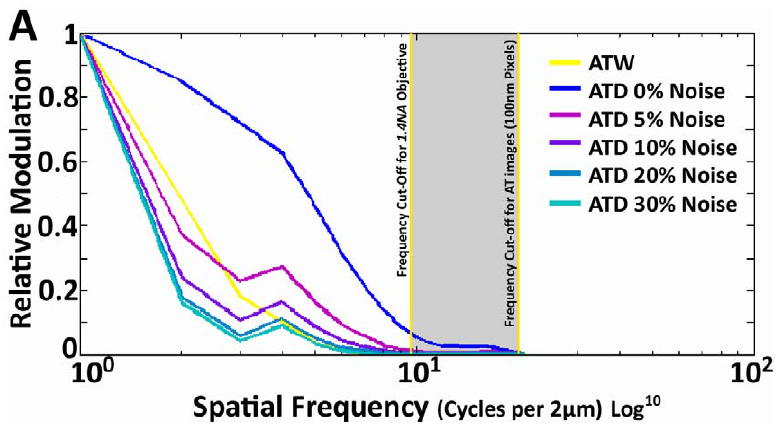
Figure 8. The effect of noise on the spatial frequency recovery of RL deconvolution. (A) This graph clearly illustrates the effect of Poisson noise on the fidelity of RL deconvolution. Poisson noise was artificially generated and added to the same image stack, and the RL was performed on those images, then the MTF of the images were calculated to demonstrate that even with a 5% injection of noise the spatial frequency recovery was significantly degraded, and for a 10% noise increase for most frequencies of the MTF the ATD is not better than ATW. Pixel size of the images were 100 nm.